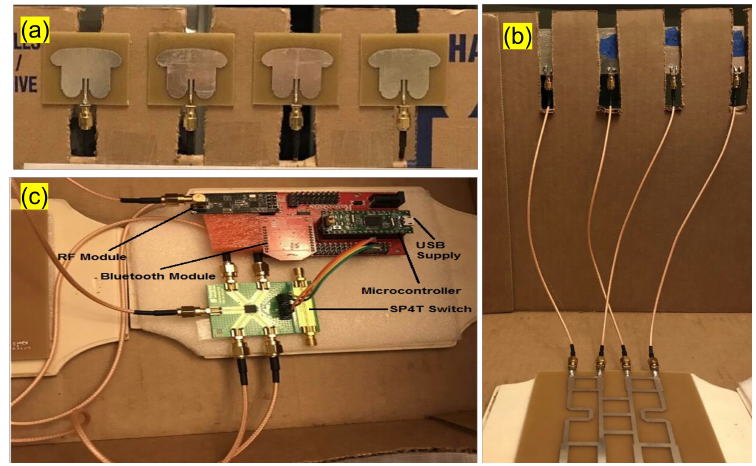
Figure 8. A complete system for approach II, ( a ) Front view consisting of 1 × 4 antenna array, ( b ) Back view showing array connected to the Butler matrix, ( c ) Control parts.